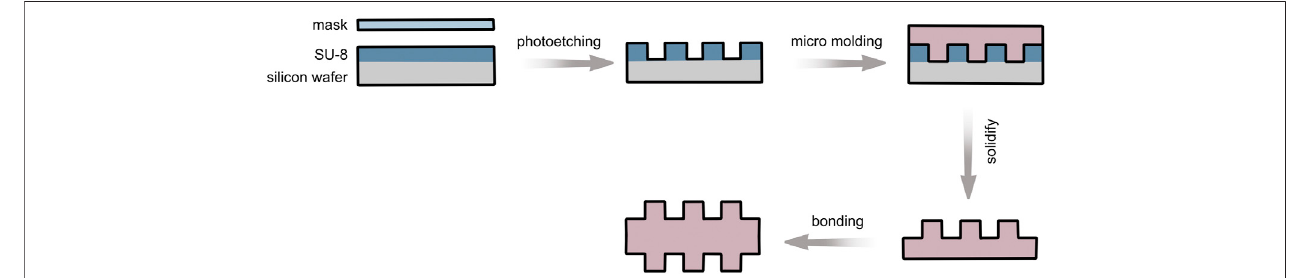
FIGURE 1 | Pattern diagram of groove structure formation on the material